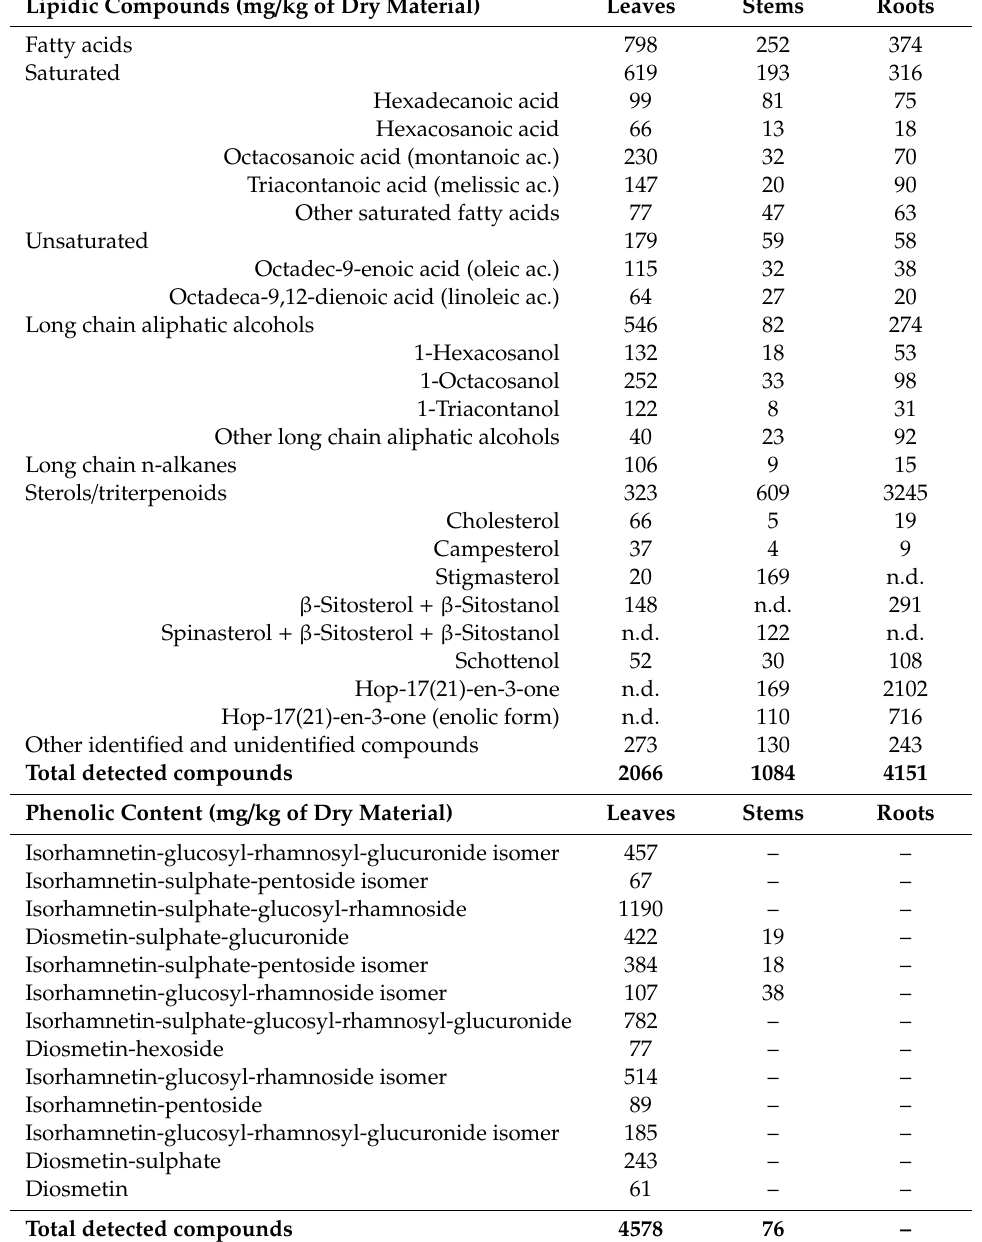
Table 2. Main compounds (mg / kg DW) identified in extracts from the leaves, stems and roots of A. portulacoides (from Vilela et al. [44],